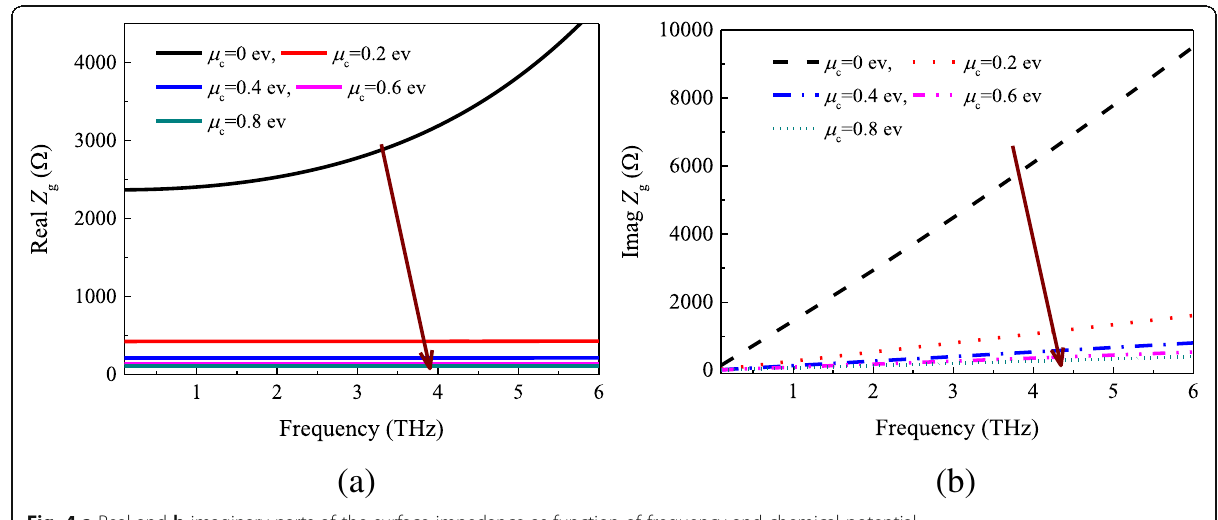
Fig. 4 a Real and b imaginary parts of the surface impedance as function of frequency and chemical